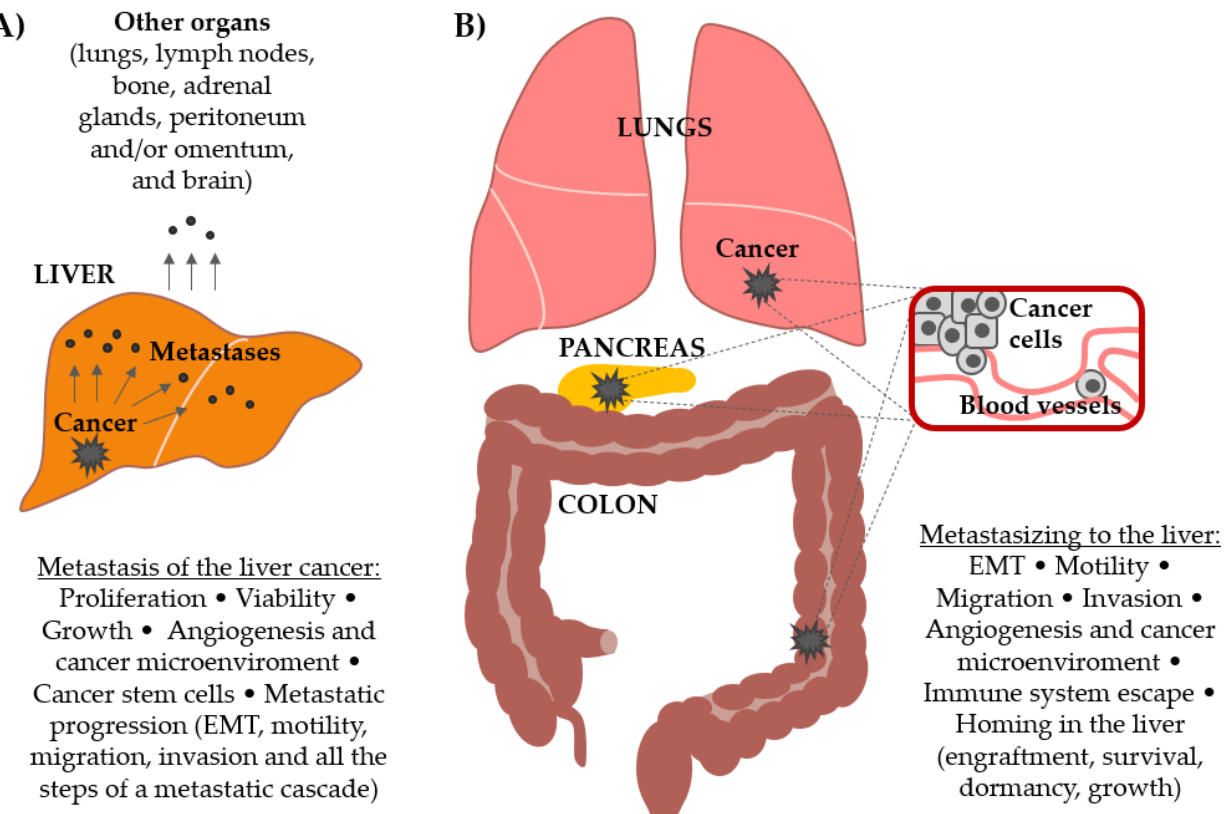
Figure 1. Involvement of the Wnt signaling pathway in ( A ) the progression and metastasis formation by primary liver cancer and in ( B ) the formation of secondary cancers in the liver (metastasis from other primary tumors, most commonly colorectal, pancreatic, melanoma, lung, breast, gastric, and prostate). Different processes that lead to metastatic outgrowth in both scenarios are delineated.